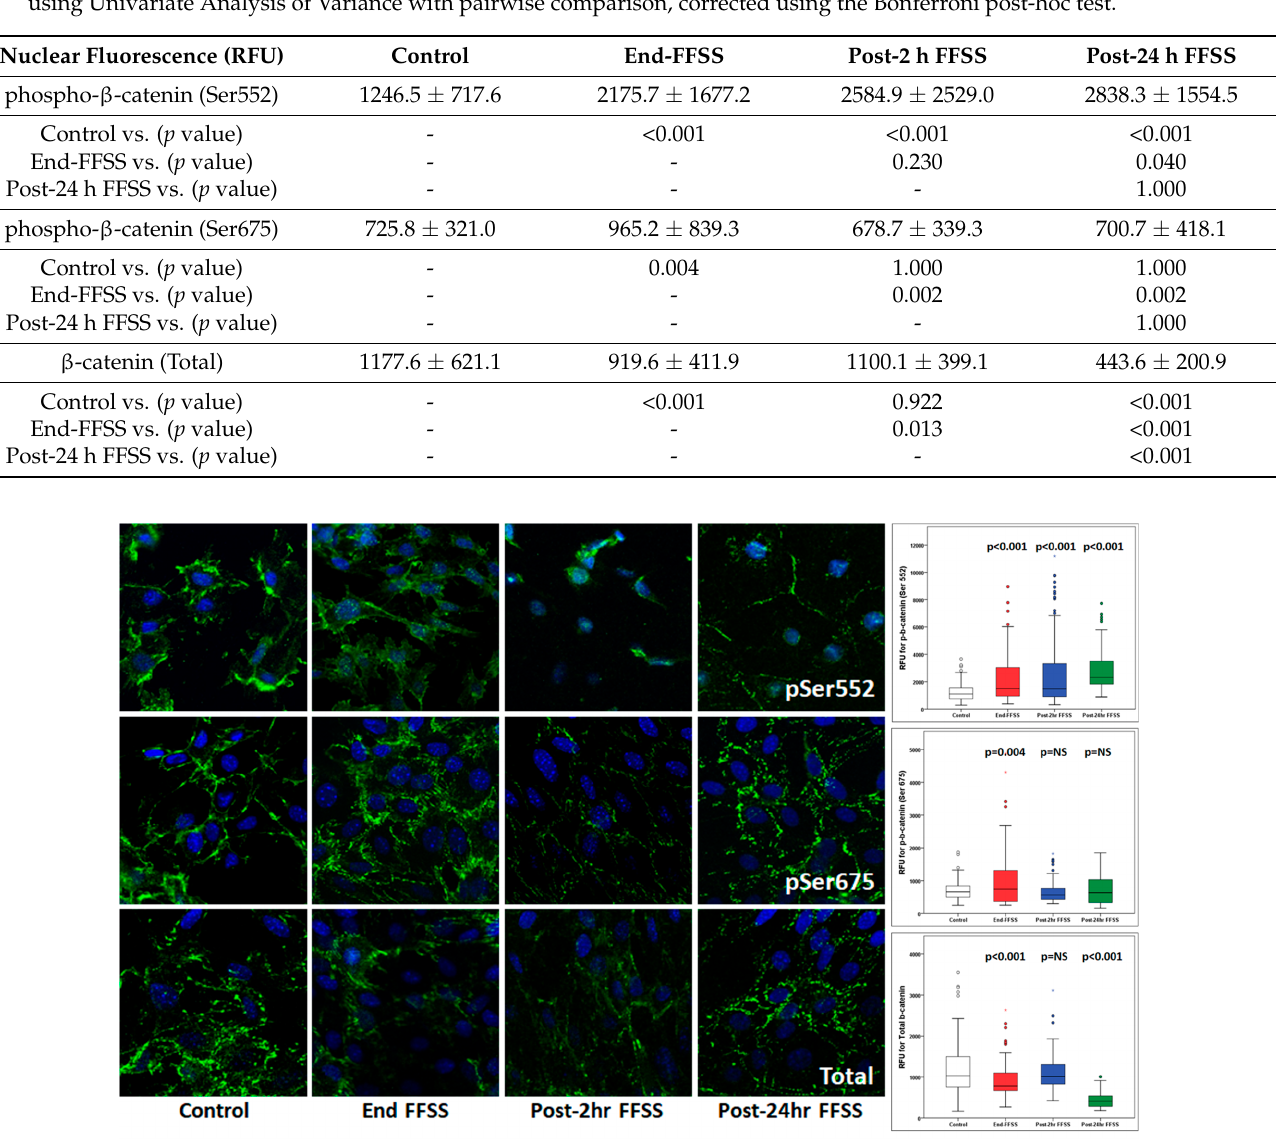
Figure 7. Phosphorylated (Ser552 and Ser675) and non-phosphorylated (Total) β -catenin in the nuclei of podocytes exposed to fluid flow shear stress (FFSS). Untreated (Control) cells were compared with podocytes exposed to FFSS at 2 dynes/cm 2 for 2 h, which were observed at the end of FFSS (End-FFSS), Post-2 h FFSS, and Post-24 h FFSS. Representative immunofluorescence images are shown. The box-plot distribution for the relative fluorescence units (RFU) in the nuclei of podocytes is on the far right.